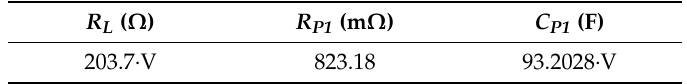
Table 2. Value of the electrical parameters which model the frecuency response of the two SCs at very low frecuencies. V is the measured voltage between the positive and negative